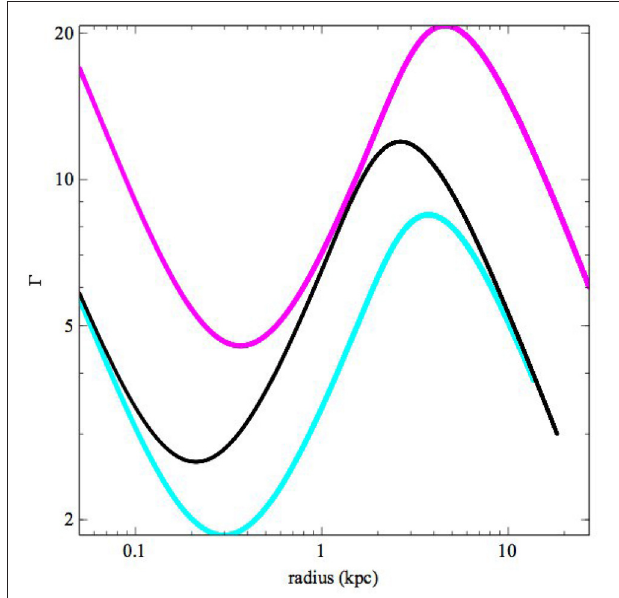
FIGURE 1 | Effective Eddington ratio as a function of radius: L = 5 × 10 46 erg/s, M sh = 5 × 10 8 M ⊙ , f dg = 1 / 150 (black, fiducial); L = 5 × 10 46 erg/s, M sh = 1 × 10 9 M ⊙ , f dg = 1 / 150 (cyan); L = 5 × 10 46 erg/s, M sh = 5 × 10 8 M ⊙ , f dg = 1 / 50